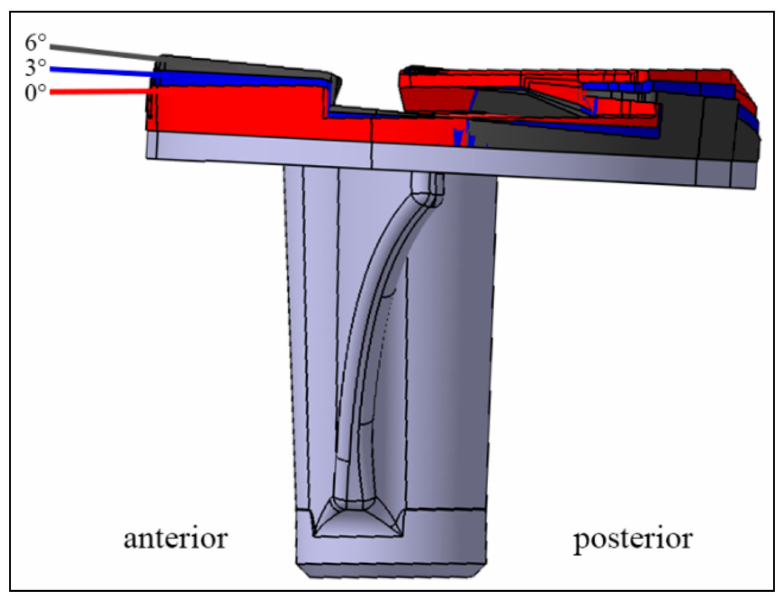
Figure 2. The fitted tibial component with the plates representing a 0 ◦ (red), 3 ◦ (blue), and 6 ◦ (dark grey) posterior tibial slope